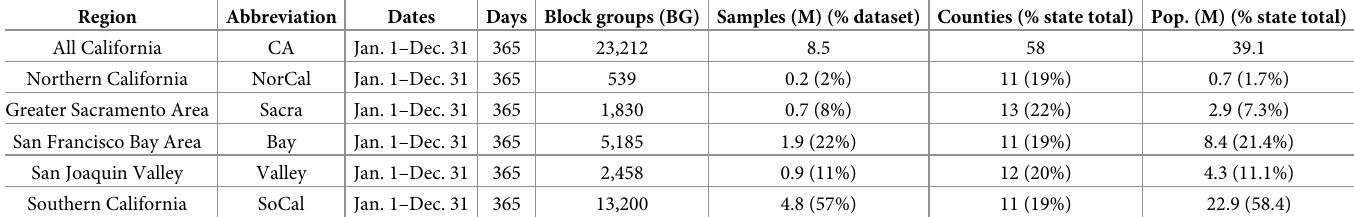
Table 1. Characteristics of Skyhook’s BG-level mobility